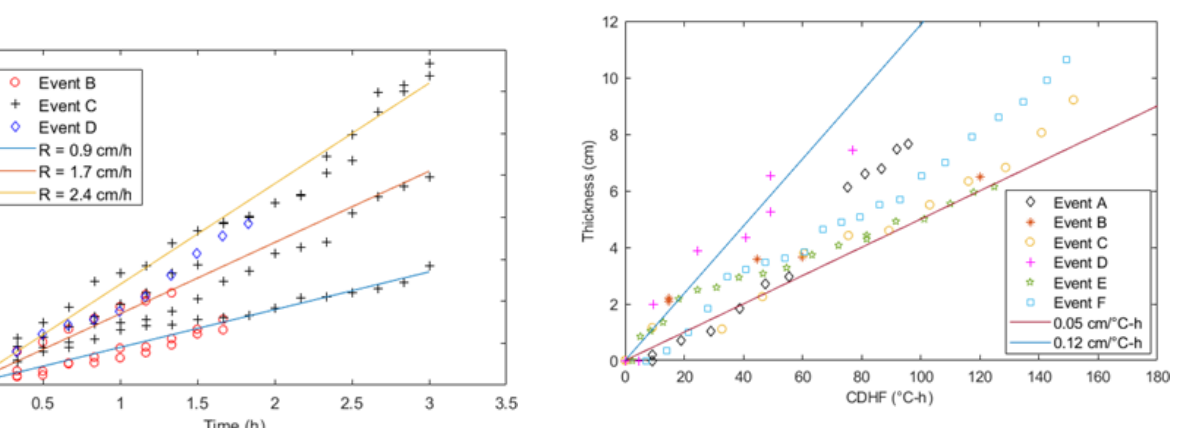
Figure 14. Anchor ice thickness growth due to frazil deposition (stages 2 and 3) against the cumulative degree hour of freezing (CDHF). The linear rates of 0.05 and 0.12cm/ ◦ C-h were added to the plot for